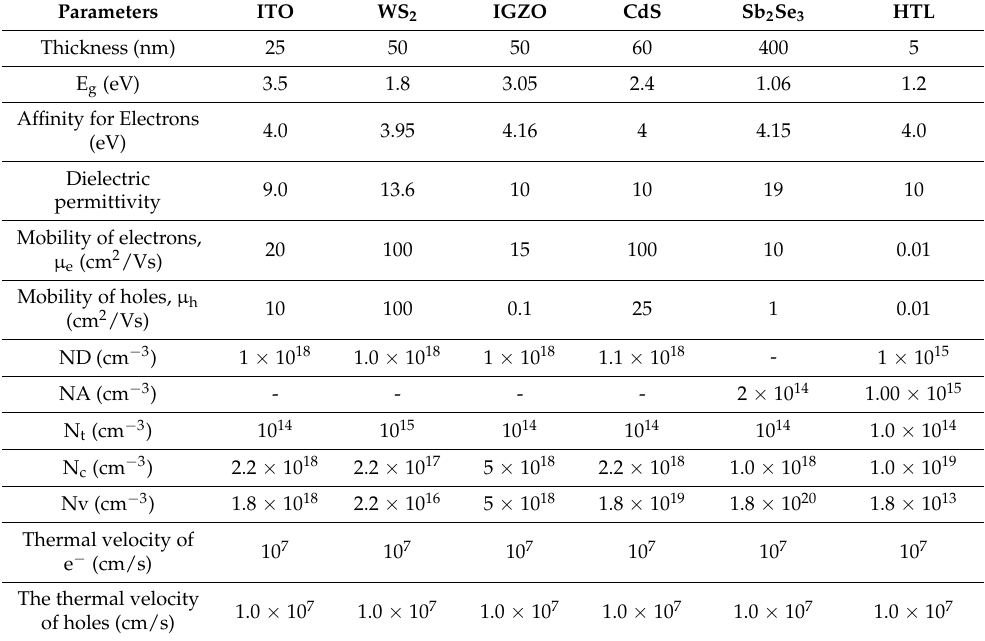
Table 1. The parameters of different layers of solar photovoltaic devices were utilized to conduct the investigation [2,7,9,10,15].